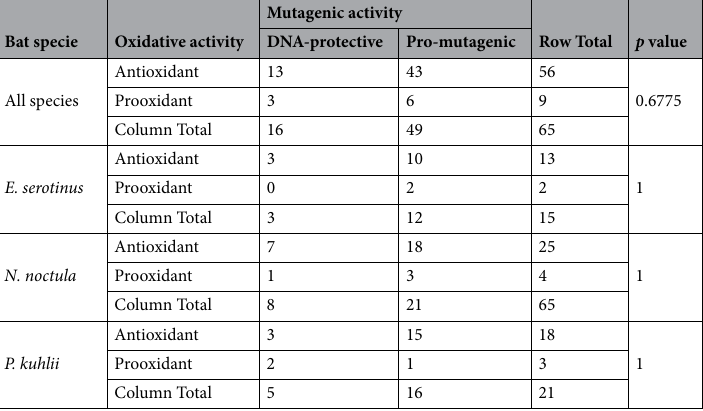
Table 1. Table representing results of Fisher exact test. There is no significant relationship between the pro- or antioxidant and pro-mutagenic or DNA-protective properties of isolated lactic acid bacteria and bacilli, most likely because of different mechanisms involved in providing these properties.